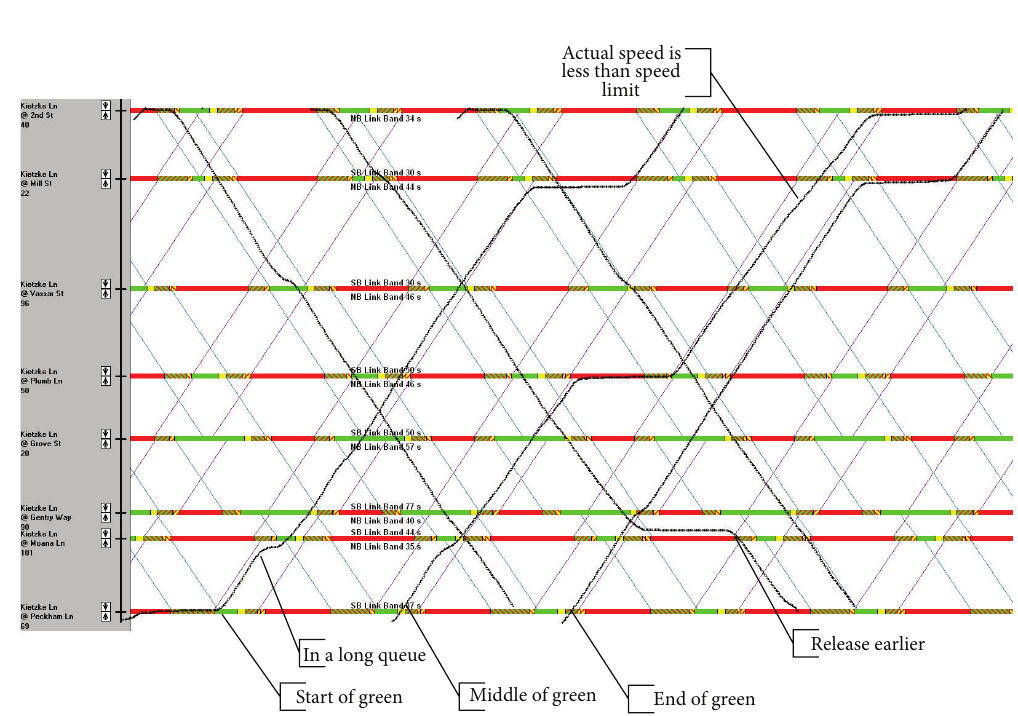
Figure 9: GPS trajectory on initial TSD on the speed of 40